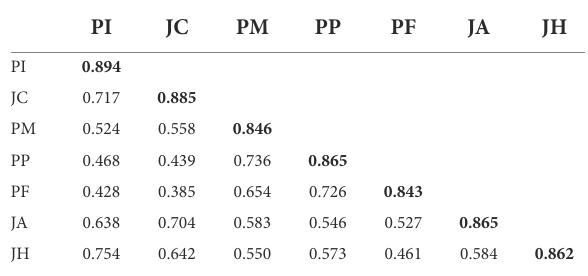
TABLE 3 Discriminant